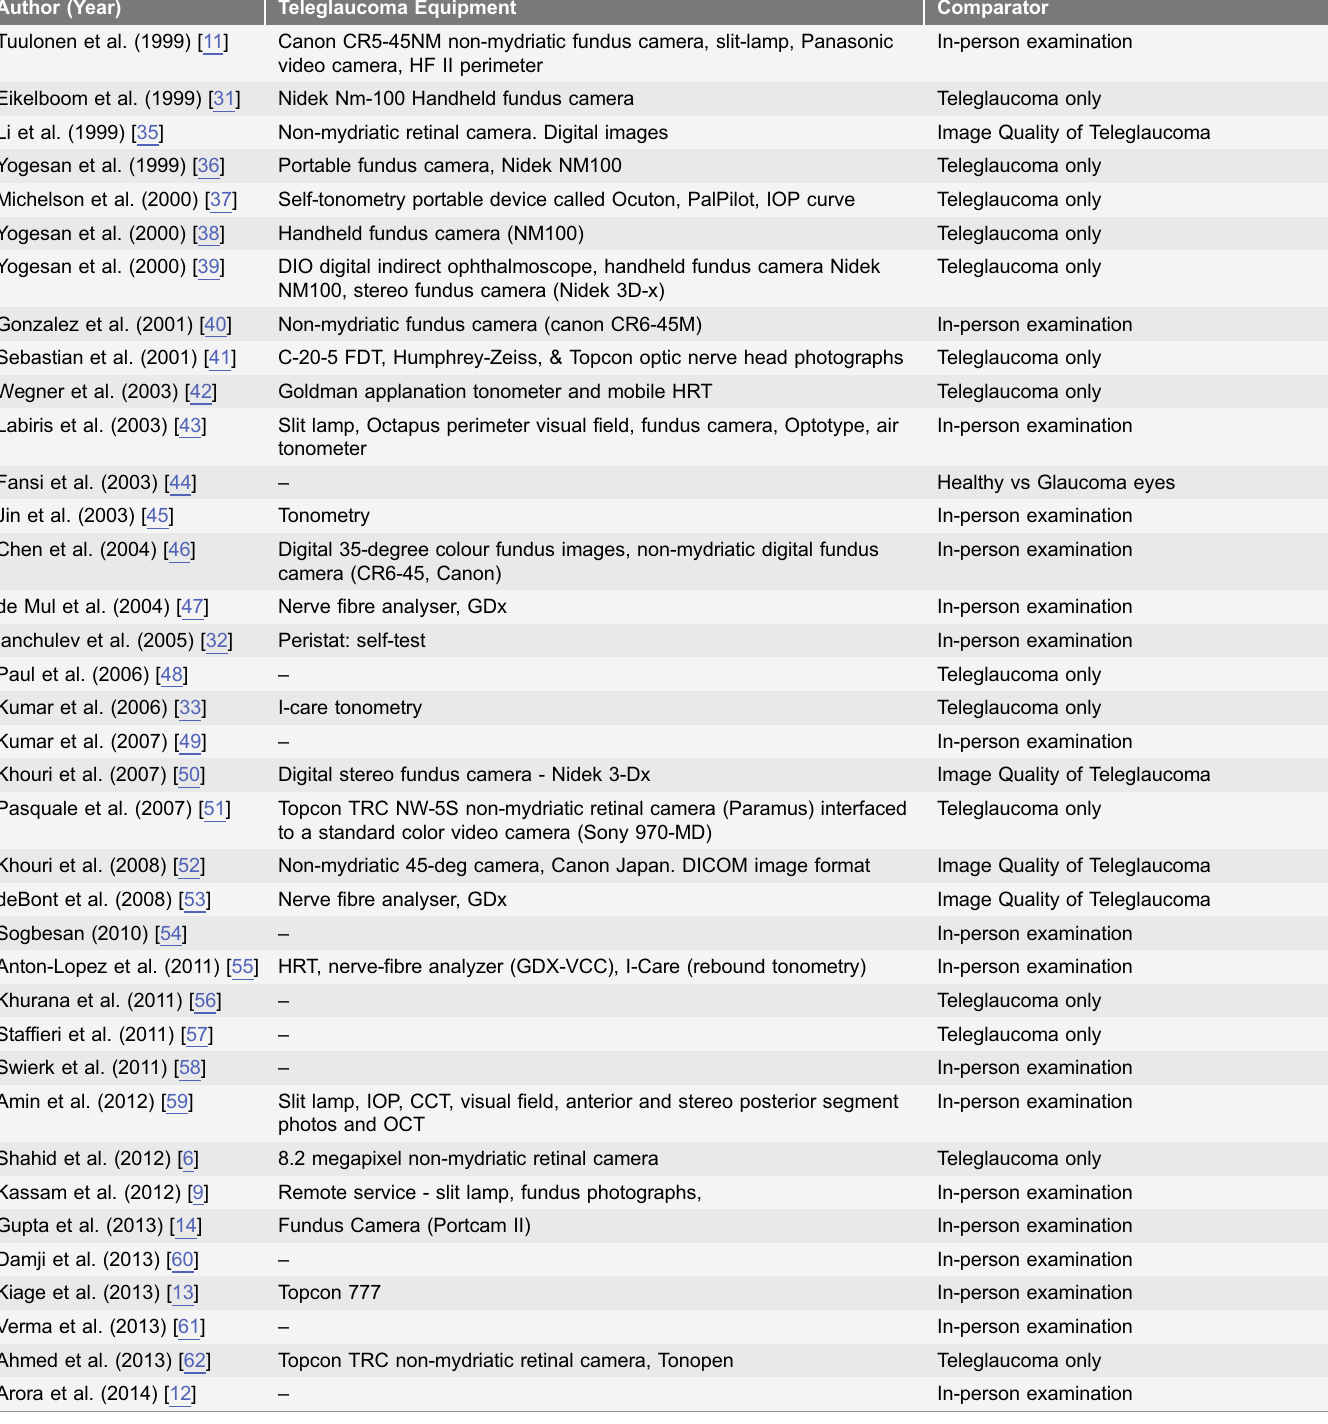
Table 3. Baseline characteristics of included studies –